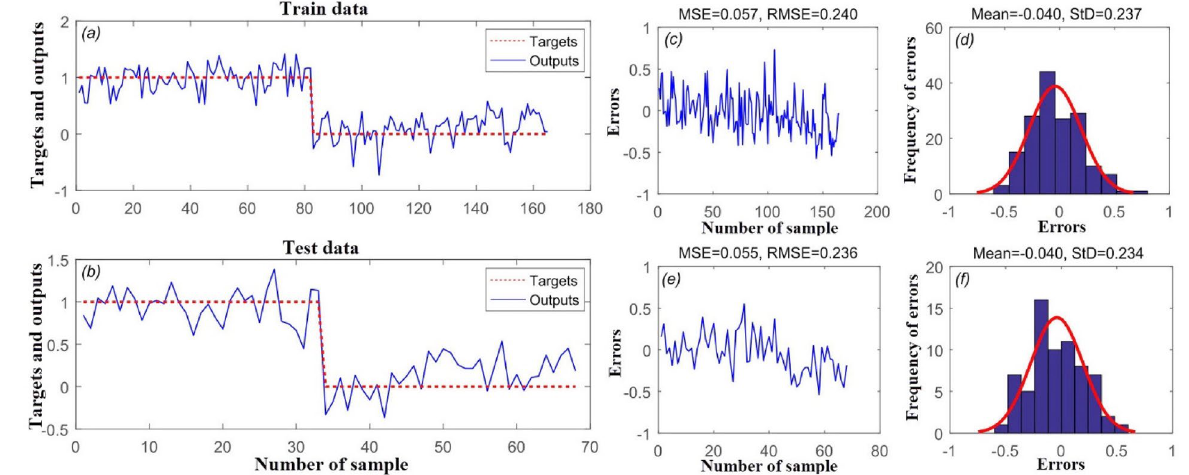
Figure 6. ( a ) Target and output Wavelet-SVR-GWO value of training data samples, ( b ) target and output Wavelet-SVR-GWO value of testing data samples, ( c ) mean squared error (MSE) and root mean square error (RMSE) value of training data samples, ( d ) frequency of errors for training data samples, ( e ) MSE and RMSE value of testing data samples, and ( f ) frequency of errors for testing data